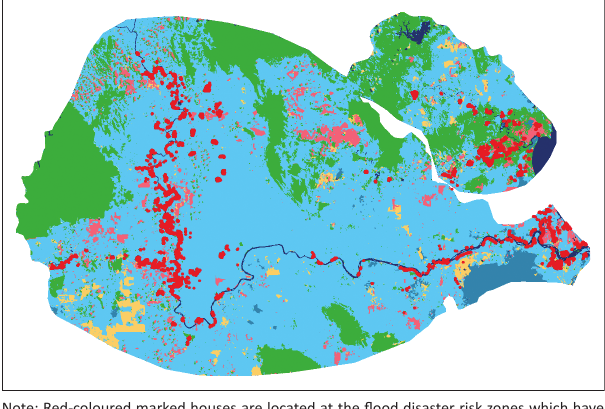
FIGURE 2: Distribution of the population that are residing in the flood disaster risk zones along the Pahang and Kuantan river